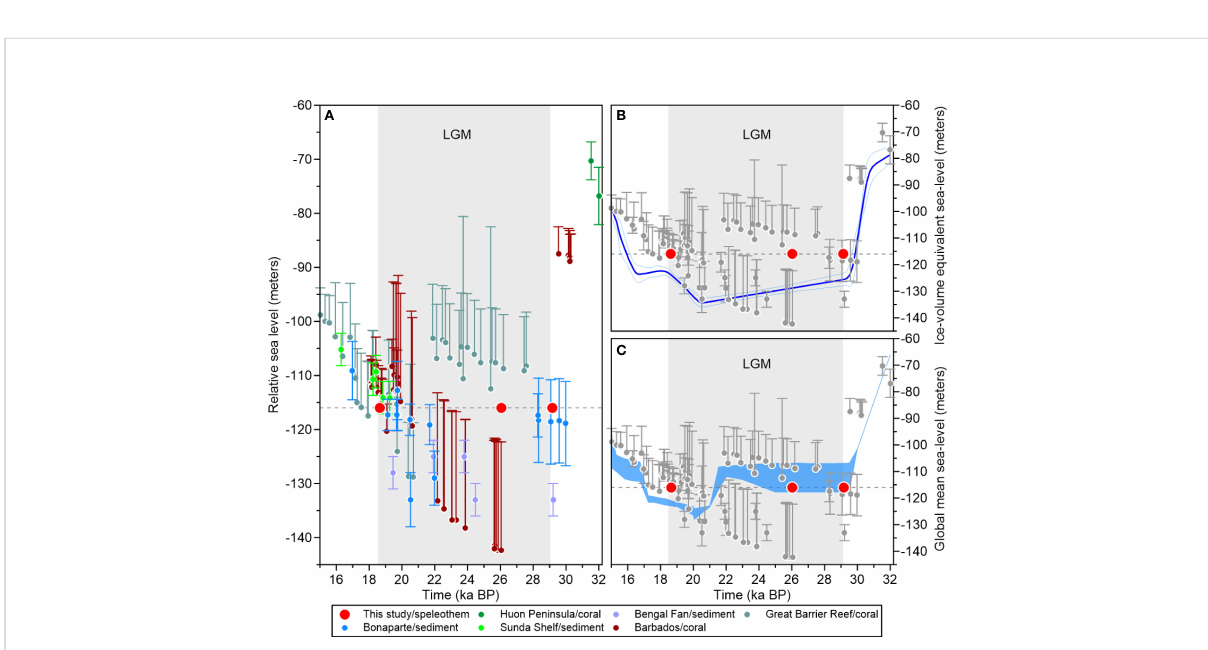
FIGURE 9 Last Glacial Maximum (LGM) sea levels with observational data and ice volume equivalent and global mean sea levels. (A) Previously documented LGM sea level data from Bonaparte Gulf (Yokoyama et al., 2000; De Deckker and Yokoyama, 2009), Huon Peninsula (Yokoyama et al., 2001), Sunda Shelf (Hanebuth et al., 2000; Hanebuth et al., 2009), Bengal Fan (Wiedicke et al., 1999), Barbados (Bard et al., 1990; Peltier and Fairbanks, 2006), and Great Barrier Reef (Yokoyama et al., 2018). (B, C) Previously constructed ice volume equivalent (Lambeck et al., 2014) and global mean sea levels (Yokoyama et al.,